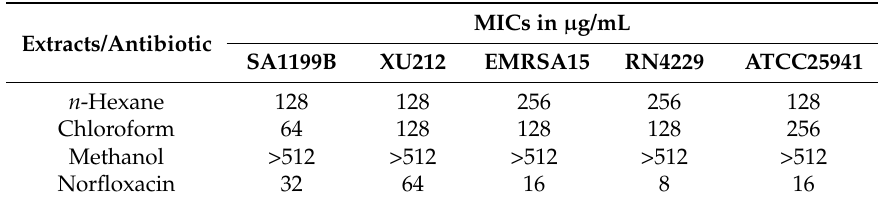
Table 1. Antibacterial activity of crude extracts against standard, multi-drug resistant (MDR) and methicillin-resistant strains of Staphylococcus aureus in µ